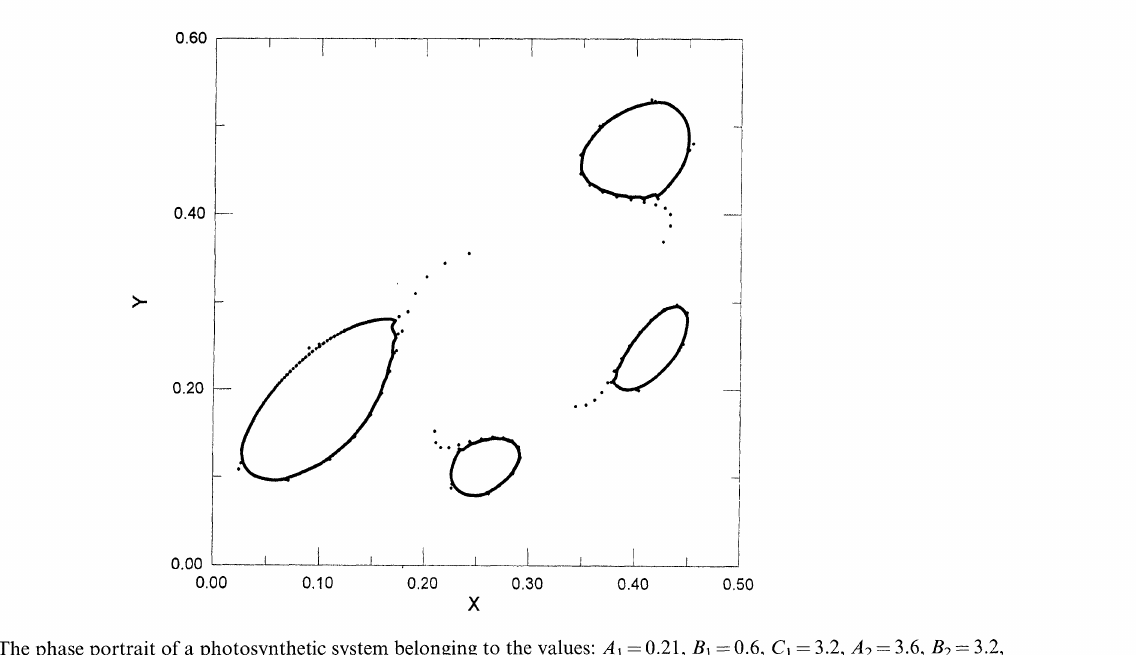
FIGURE 5 The phase portrait of a photosynthetic system belonging to the values: A 0.21, B 0.6, C 3.2, A2 3.6, B 2-- 3.2, C2 1.2, Xo 0, Y0 0.2.